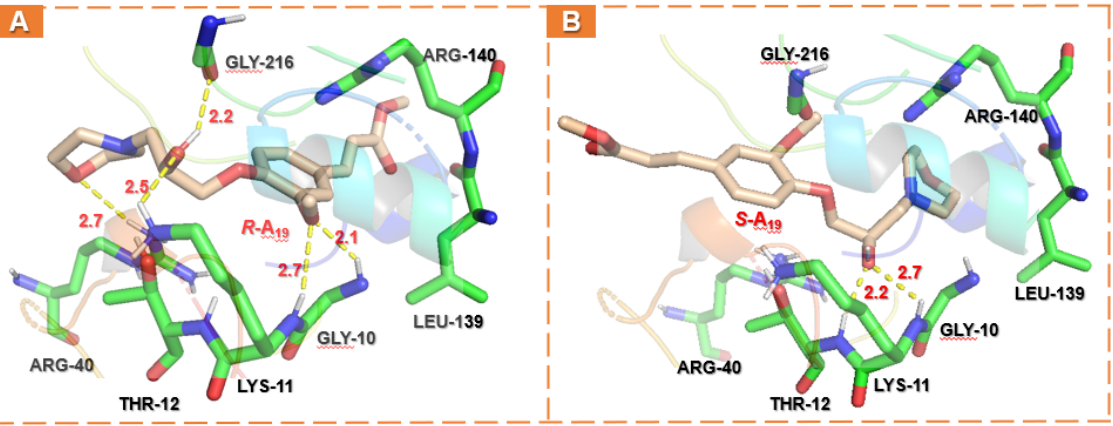
Figure 10. Molecular docking models of the TMV helicase with R ‐ A 19 ( A ) or S ‐ A 19 ( B ), respectively. 2.6. Effect of Target Compounds on GFP ‐ Labeled TMV and Relative Expression Levels of Hel ‐ icase In Vivo